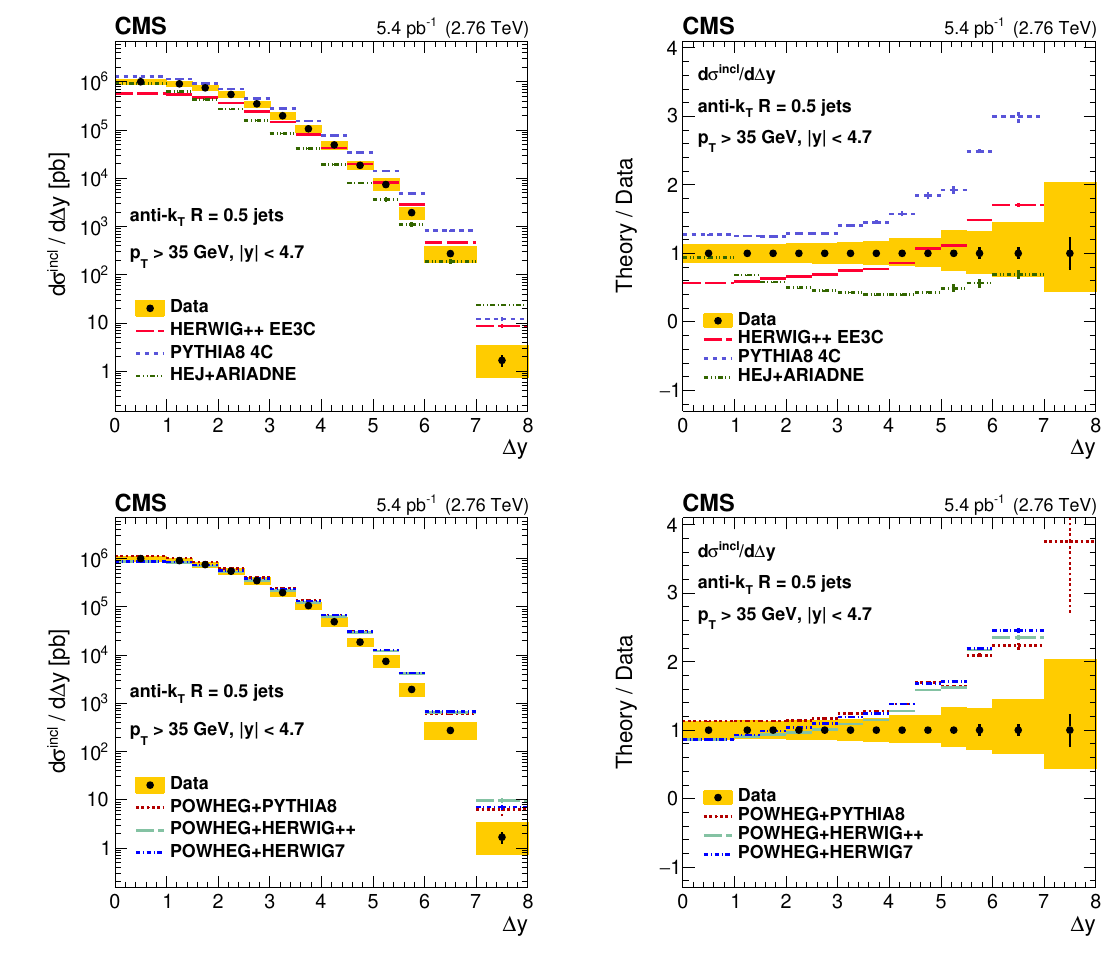
Figure 2 . Differential cross section d σ incl / d∆ y for inclusive dijet production. The upper and lower rows present the comparison with different MC models. The plots on the left present the cross sections and those on the right the ratio of theory to data. The systematic uncertainties are indicated by the shaded bands and the statistical uncertainties by the vertical